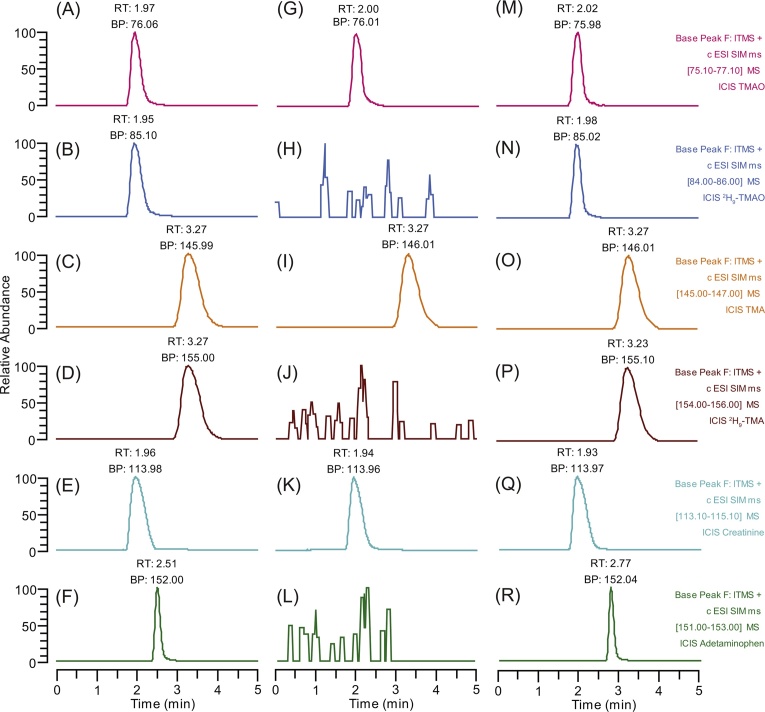
Reconstructed ion chromatograms (RICs) for pure standards (A-F), urine (G-L) and urine spiked with standards (M-R). RIC of SIM at m/z 76, corresponding to TMAO (A); RIC of SIM at m/z 85, corresponding to 2H9-TMAO (B); RIC of SIM at m/z 146, corresponding to derivatized TMA (C); RIC of SIM at m/z 155, corresponding to derivatized-2H9-TMA (D); RIC of SIM at m/z 114, corresponding to creatinine (E); RIC of SIM at m/z 152, corresponding to acetaminophen (F). RICs of urine for SIMs at m/z 76, endogenous TMAO (G), m/z 146, endogenous derivatized TMA (I) and m/z 114, endogenous creatinine (K); and RICs of a urine sample spiked with TMAO, 2H9-TMAO, TMA, 2H9-TMA, creatinine and acetaminophen for SIMs at m/z 76 (M), m/z 85 (N), m/z 146 (O), m/z 155 (P), m/z 114 (Q) and m/z 152 (R), respectively.